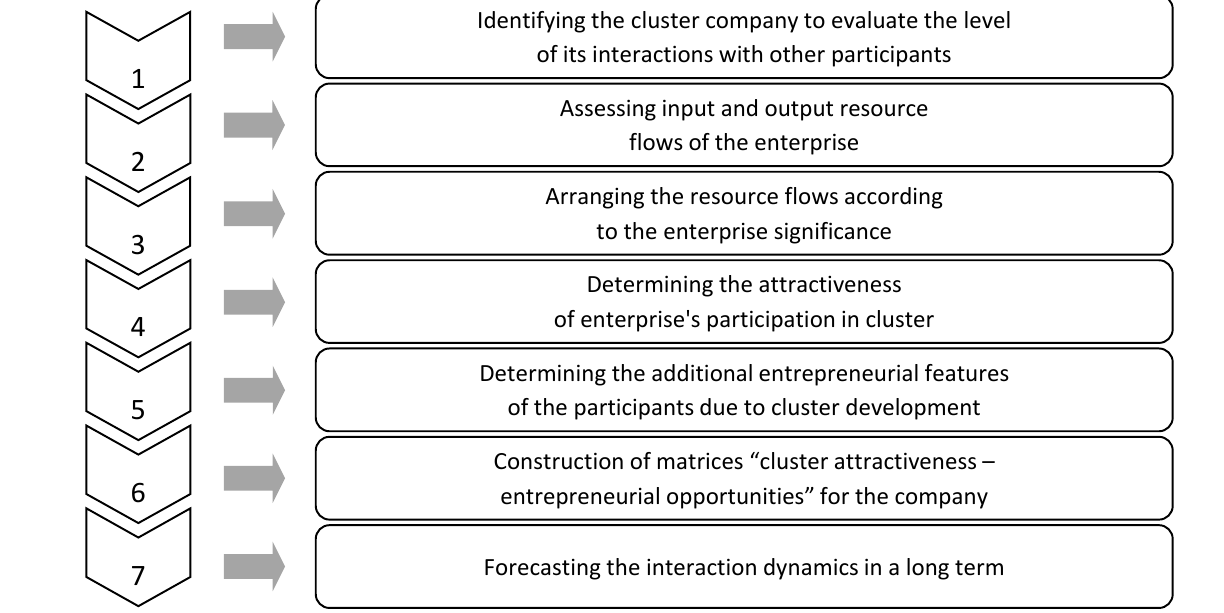
Figure 3. Algorithm of positioning the enterprise in a tourism